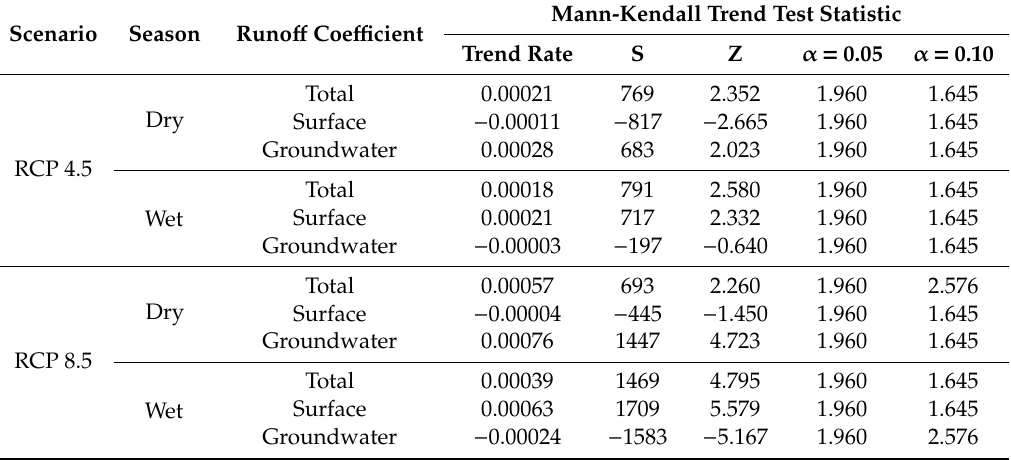
Table 6. The Mann–Kendall trend test statistics of runo ff coe ffi cient and components. The trend rates are based on the multi-model ensemble mean of 13 results of the value of the change in the runo ff coe ffi cient and its components in 109 subbasins for each year of the period 2006–2009.